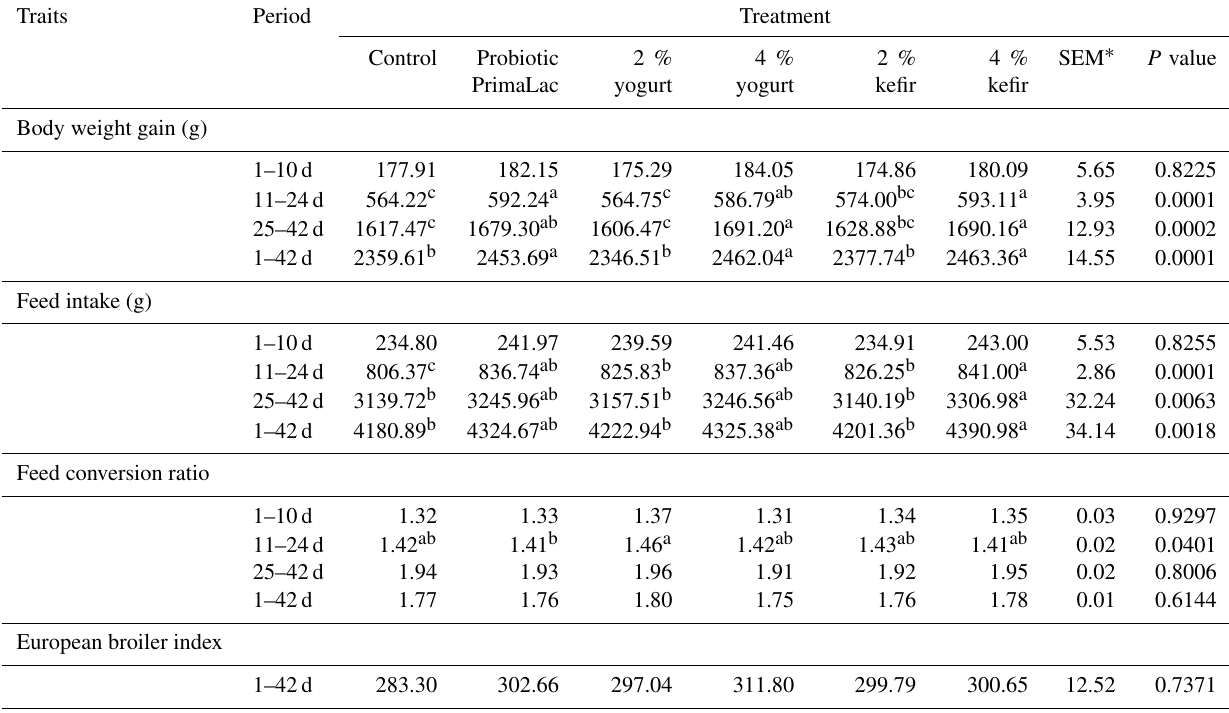
Table 3. The effects of using kefir, yogurt, and probiotic on performance of broiler chickens. Traits Period Treatment Control Probiotic 2 % 4 % 2 % 4 % SEM ∗ P value PrimaLac yogurt yogurt kefir kefir Body weight gain (g) 1–10d